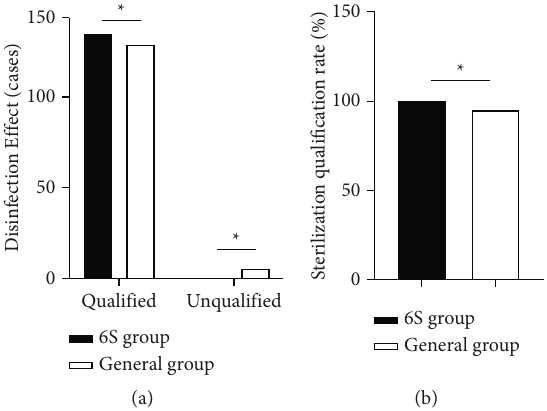
Figure 2: Analysis of the disinfection effect of dental medical devices in two groups. (a) Disinfection effect (cases). (b) Sterilization qualification rate (%). The 6S group compared to the general group, ∗ P > 0 . 05.